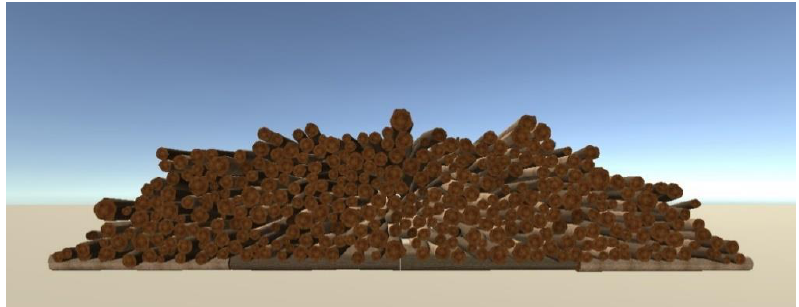
Figure 1. Simulated